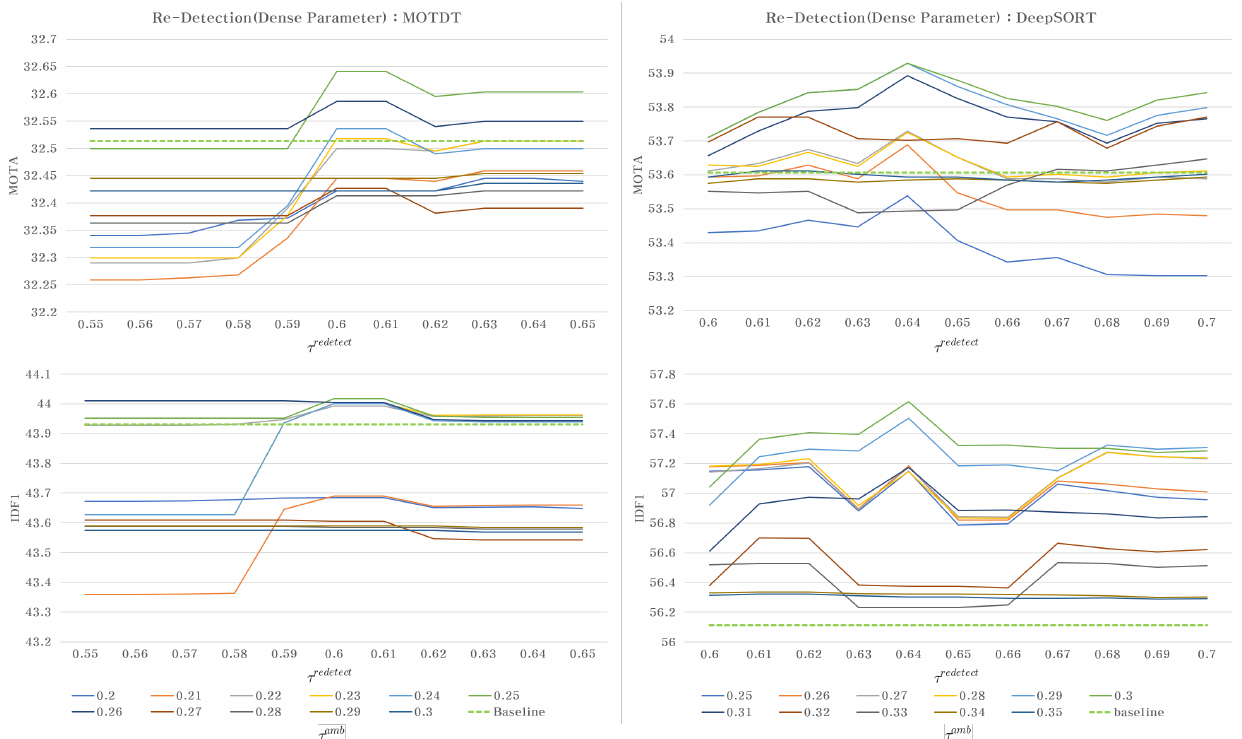
Figure 11. The experimental results of the second experiment to find delicate parameters based on the parameters that performed the best in the first experiment. τ redetect and τ amb vary in units of 0.01 ranged over the value of the base parameter.